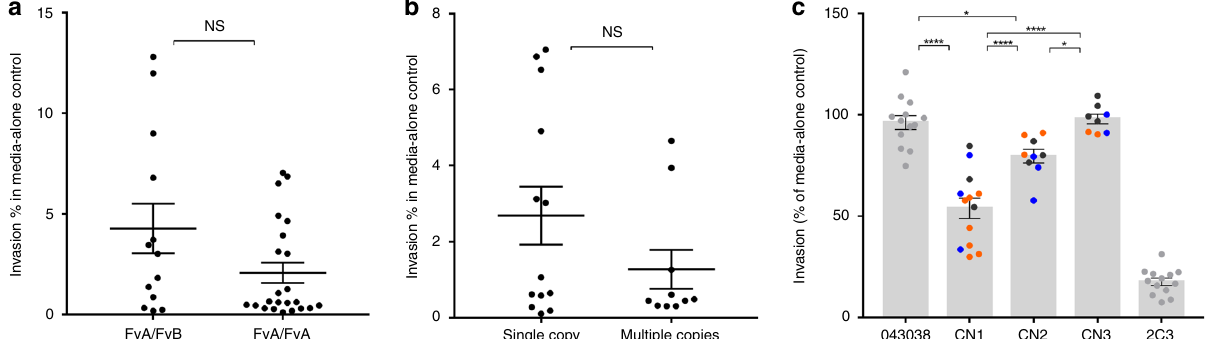
Fig. 4 Variation in reticulocyte invasion inhibition by human antibodies is not dependent on the polymorphism of the Duffy receptor of reticulocytes. a Similar invasion percent of parasites in FyA/FyB and FyA/FyA reticulocytes in absence of antibodies (NS: non-signi fi cant, Mann-Whitney U = 108, P = 0.1794). Each dot represents the invasion percent of a different clinical isolate with 1 to 3 technical replicates per isolate. Mean± SEM. b Similar invasion percent in FyA/FyA reticulocytes between single and multi copies pvdbp parasites in absence of antibodies (Mann-Whitney U = 47, P = 0.2768). Each dot represents the invasion percent of a different clinical isolate with 1 to 3 technical replicates per isolate. Mean ± SEM. c The pvdbp copy number of parasites drives variation in inhibition of invasion in FyA/FyA reticulocytes by human antibodies. Pooled invasion percent data in presence of 100 μ g ml − 1 of humabs (black 099100, blue 053054, orange 092096) of isolates with one copy (CN1), two copies (CN2) or three copies (CN3) of pvdbp. ANOVA F (4, 51) = 93.91, P < 0.0001, Tukey ’ s post-hoc tests, * P < 0.05, **** P < 0.0001. Each dot represents the invasion percent of a different clinical isolate with 1 to 3 technical replicates per isolate. Mean ± SEM. Source data are provided as a Source Data fi